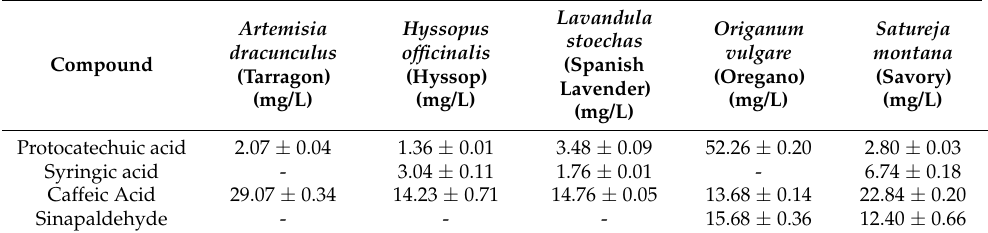
Artemisia dracunculus (Tarragon) (mg/L)